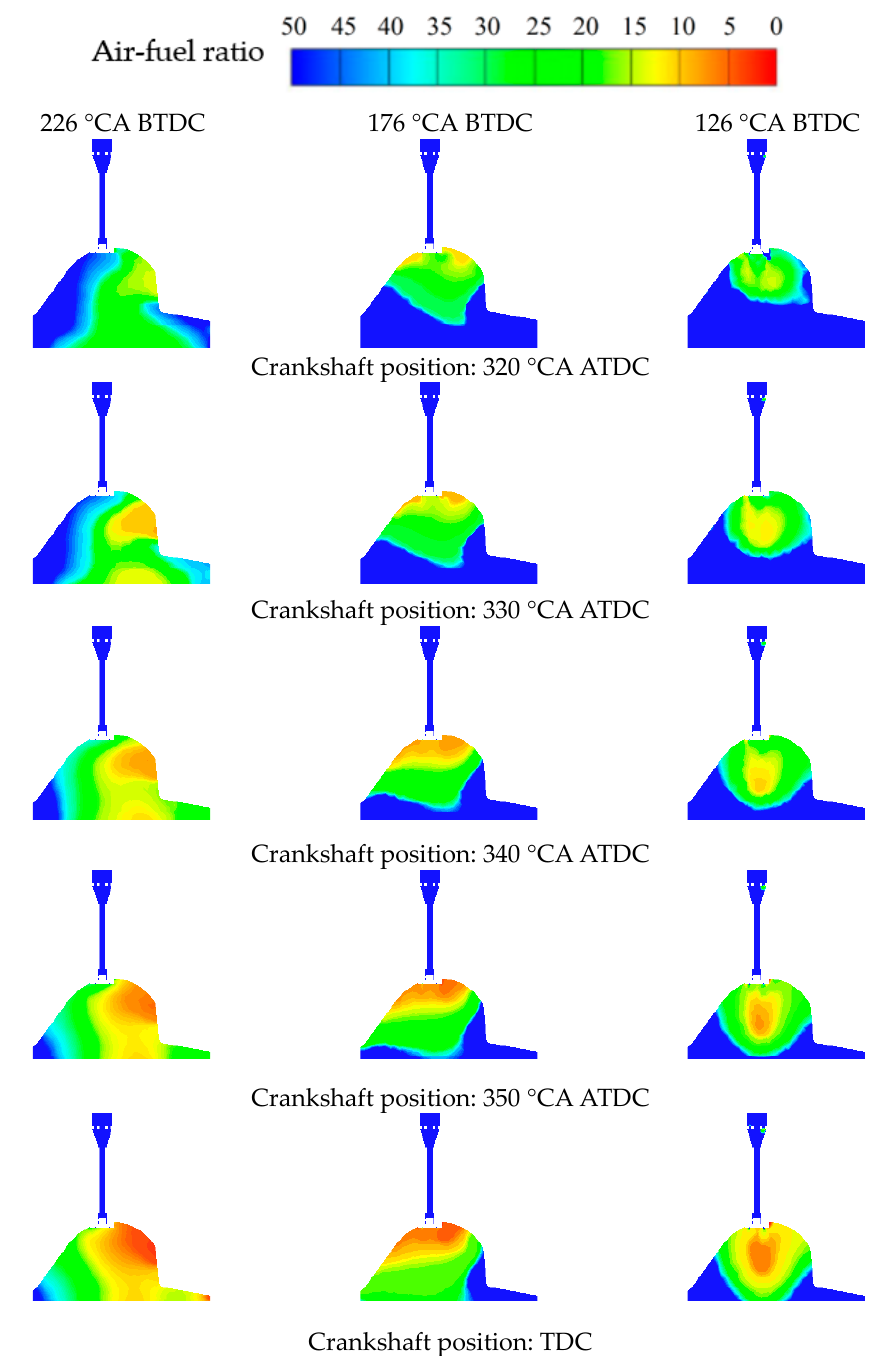
Figure 8. Distribution of mixture concentration in-cylinder at different injection timings.